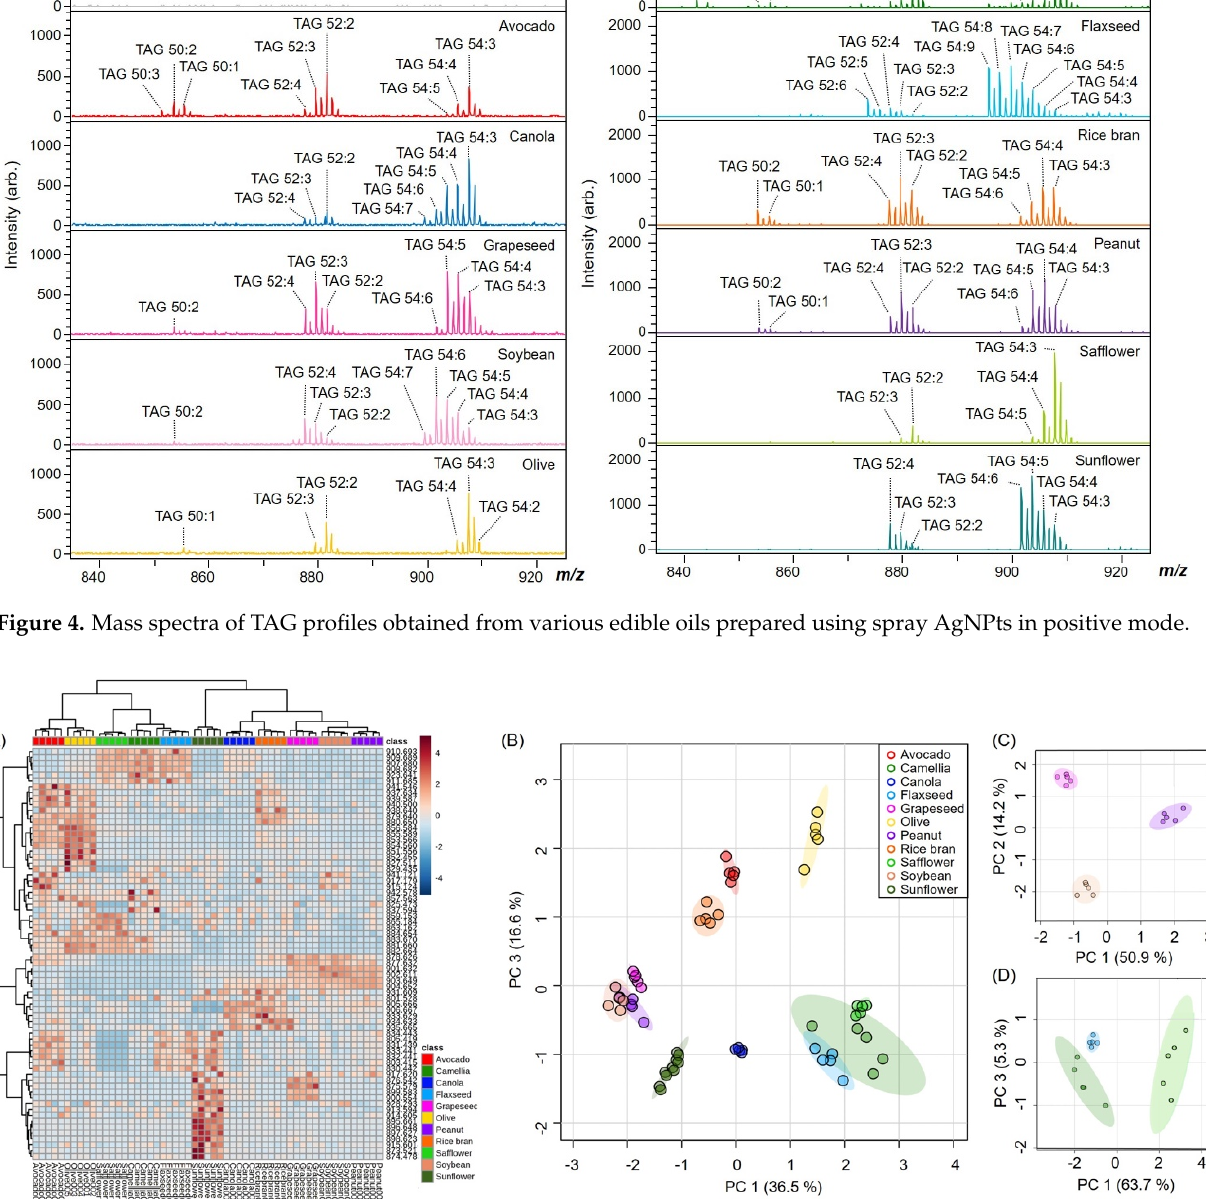
Table 1. Division of edible oils on the basis of their SALDI mass spectra and heatmap results.